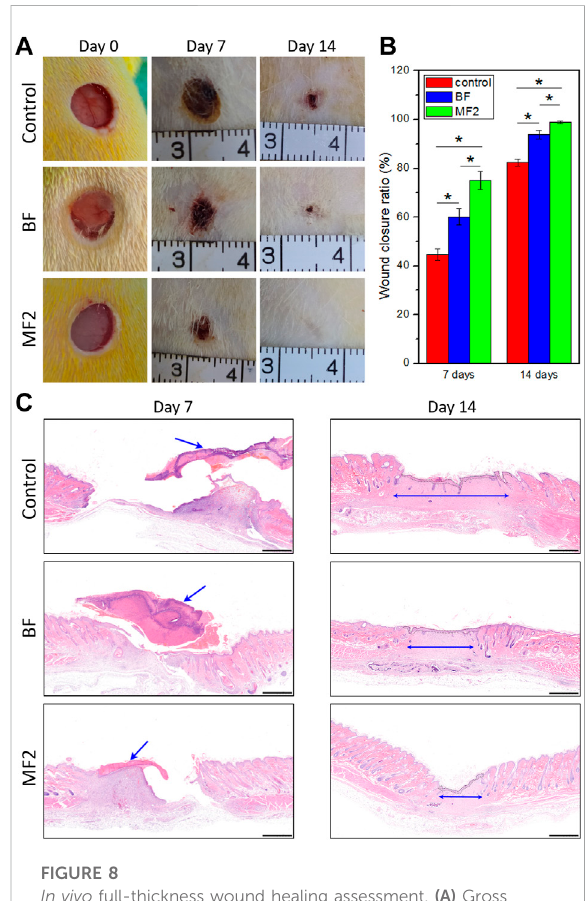
FIGURE 8 In vivo full-thickness wound healing assessment. (A) Gross observation photographs of the wound treated with different fi lms for various days. (B) Corresponding wound closure ratio. (C) H&E staining of the wounds from different groups (scale bar: 1 mm). The arrows indicate blood scabs and the edge of the wounds on days 7 and 14, respectively. The formed epithelium after 14 d of treatment is highlighted with black dotted lines. * p <